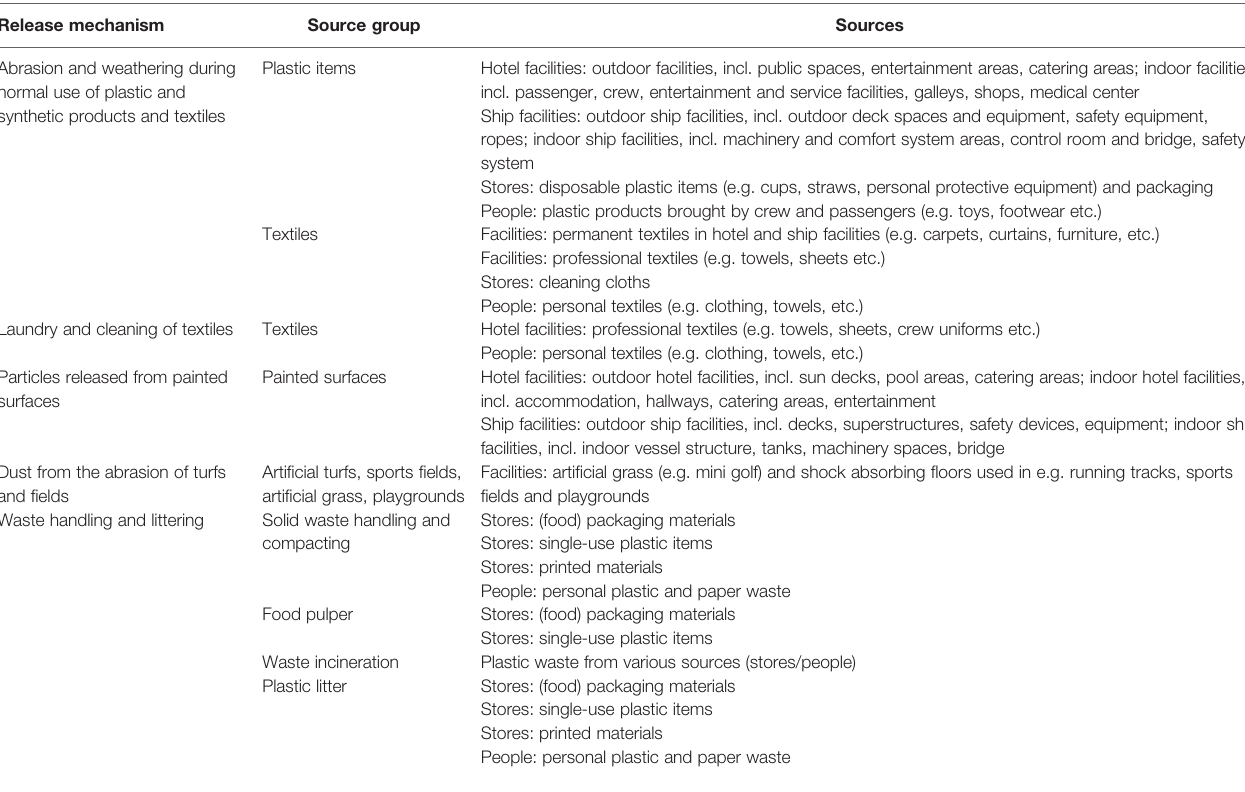
TABLE 6 | Secondary microplastic release mechanisms and sources with relevance to cruise ship